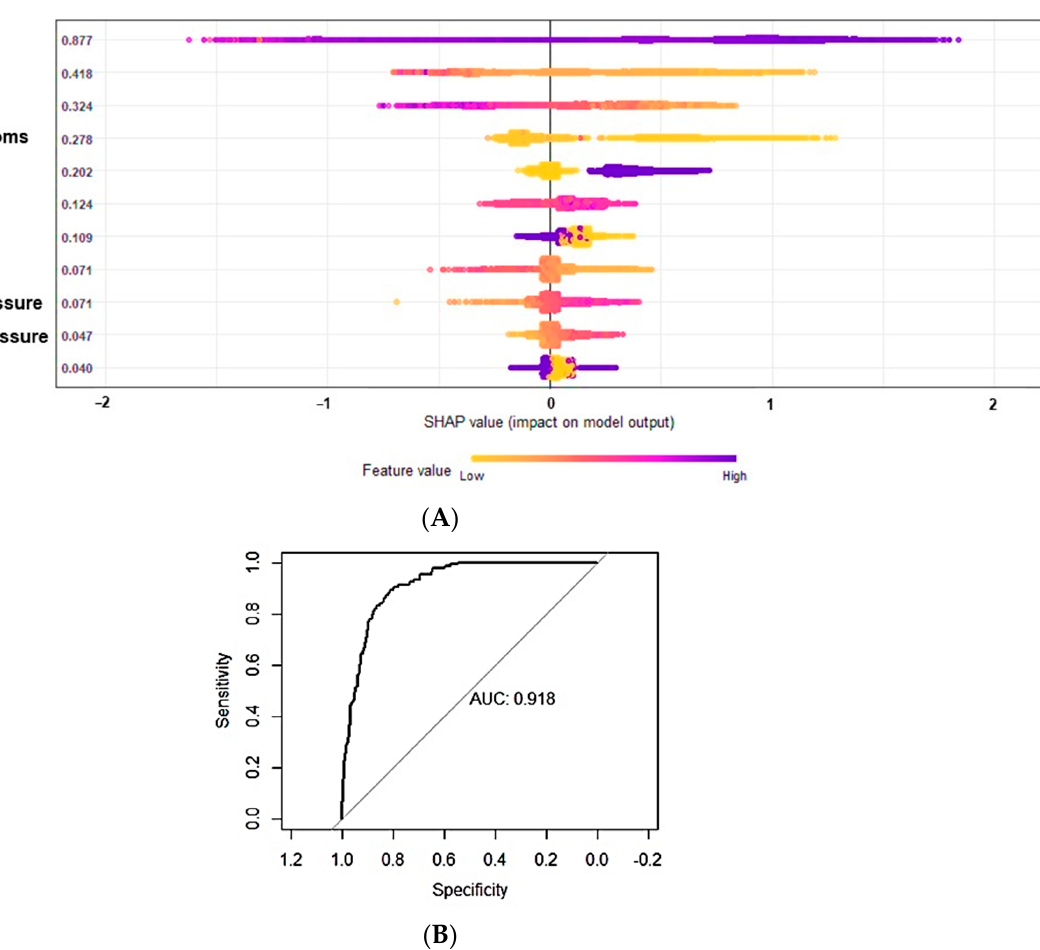
Figure 2. ( A ) Variables in order of importance using the reduced predictive model using SHAP or SHAPley Additive exPlanation plot. ( B ) ROC curve analyses with the area under the curve of 0.9181 (95% CI, 0.9001 to 0.9361).